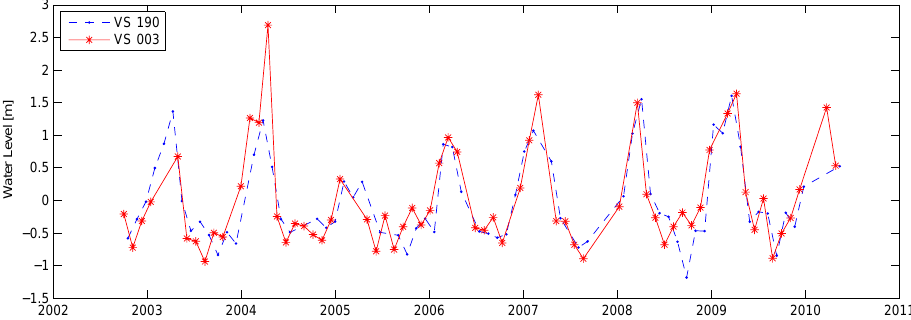
Fig. 3. Data from altimetry VS 003 (70m wide) and VS 190 (75m wide) located on the Lungwebungu River in North Western Zambia.